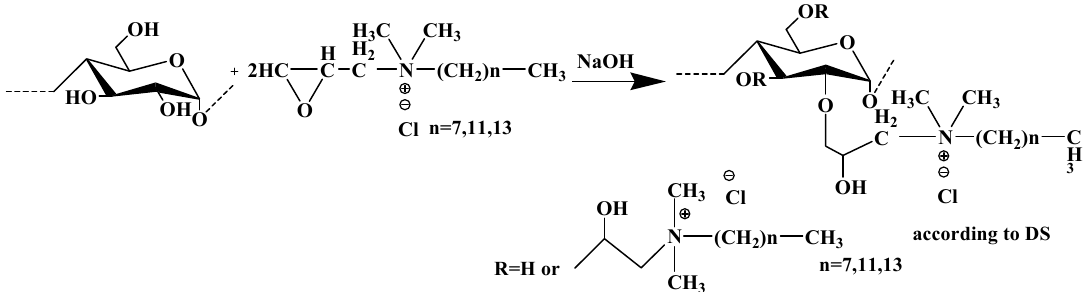
Figure 14. Synthesis scheme of cationic starch derivatives. Taken from reference [62] with permission of Elsevier.